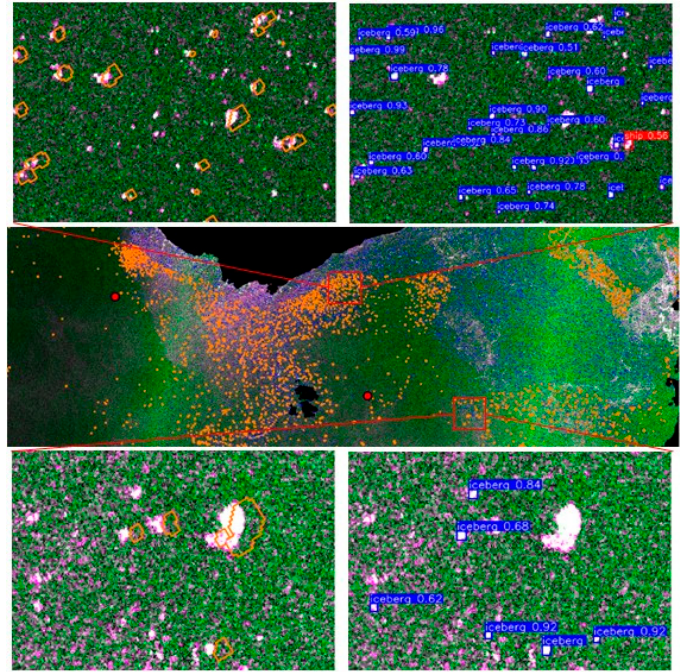
Figure 6. 20 April 2020. Validation area detection output, orange polygons and red dots are validation objects. Blue marks are iceberg detections, and red marks are ship detection (too few to see in the figure).